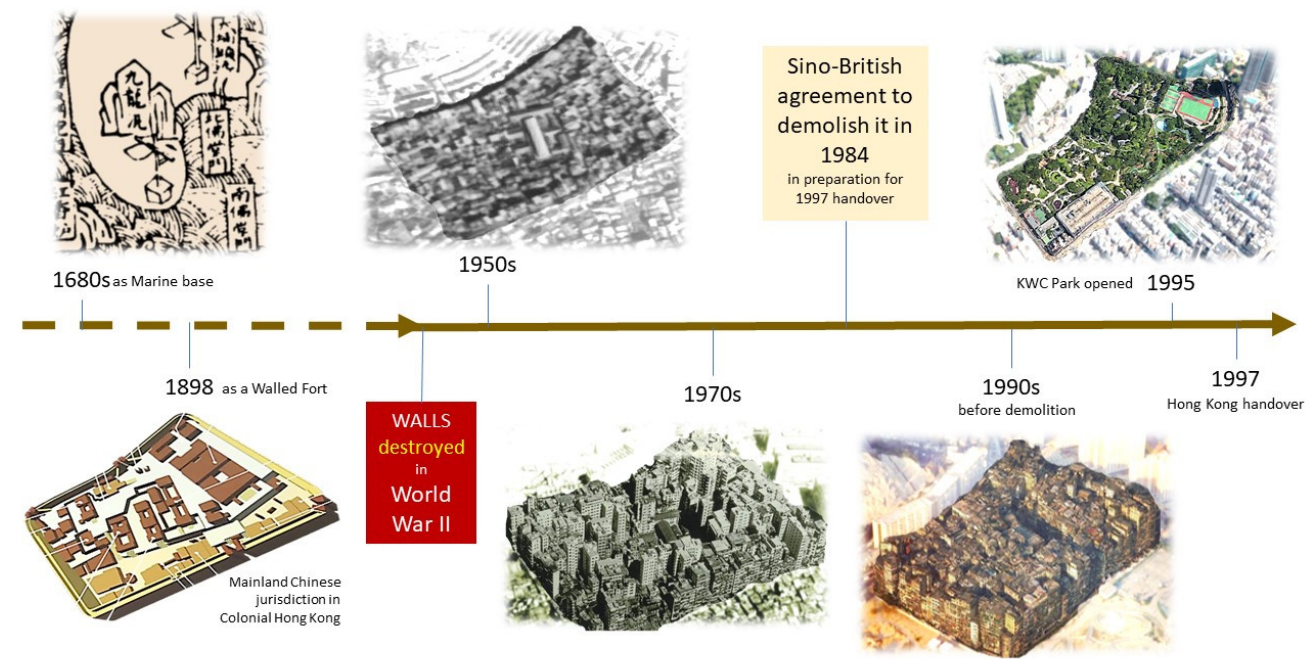
Figure 3. Simplified timeline of the KWC’s history.